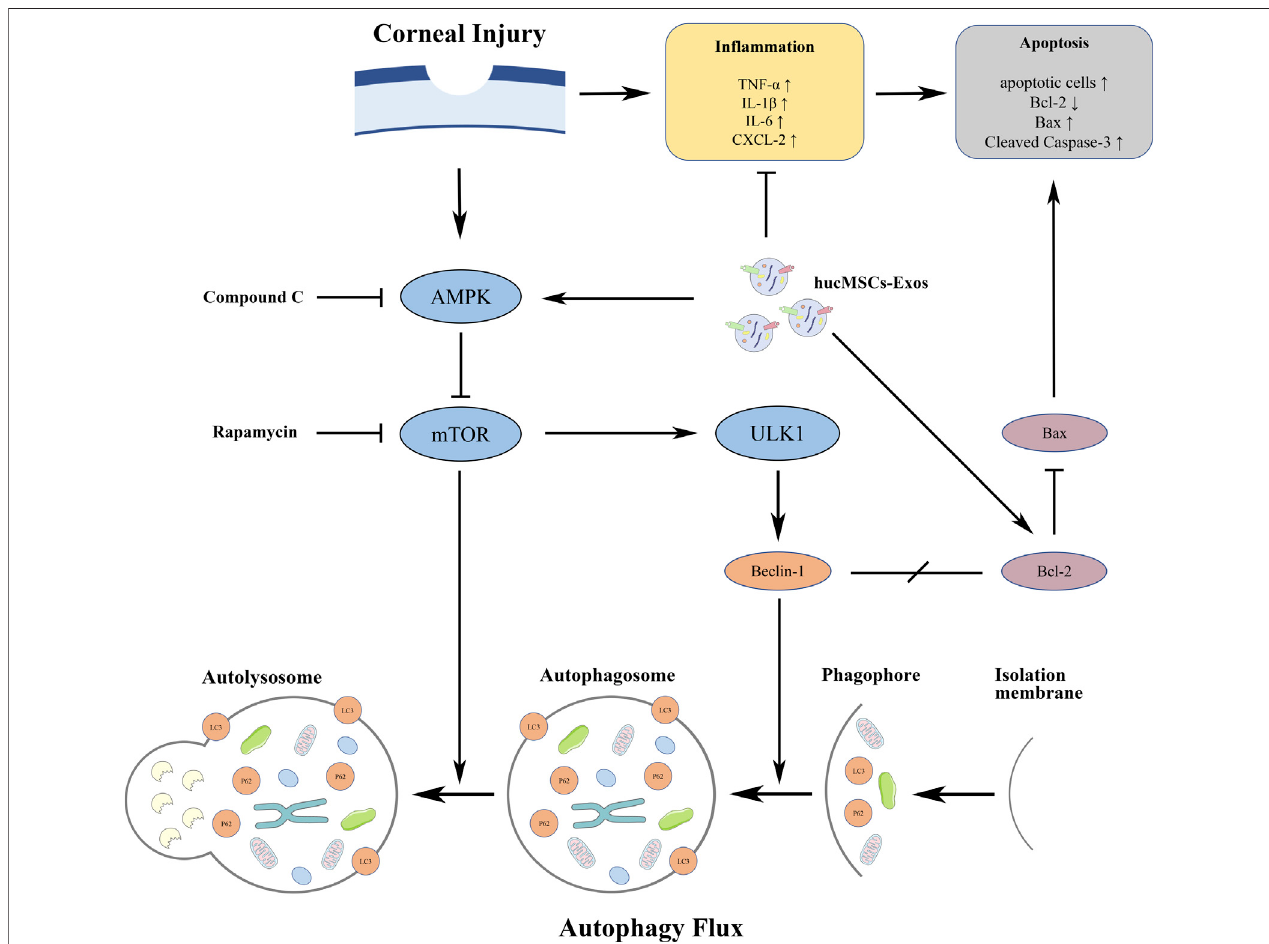
FIGURE 9 | Diagram of the proposed mechanisms underlying the functions of hucMSC-Exos and hucMSC-Exos combined with autophagy regulators on corneal injury.